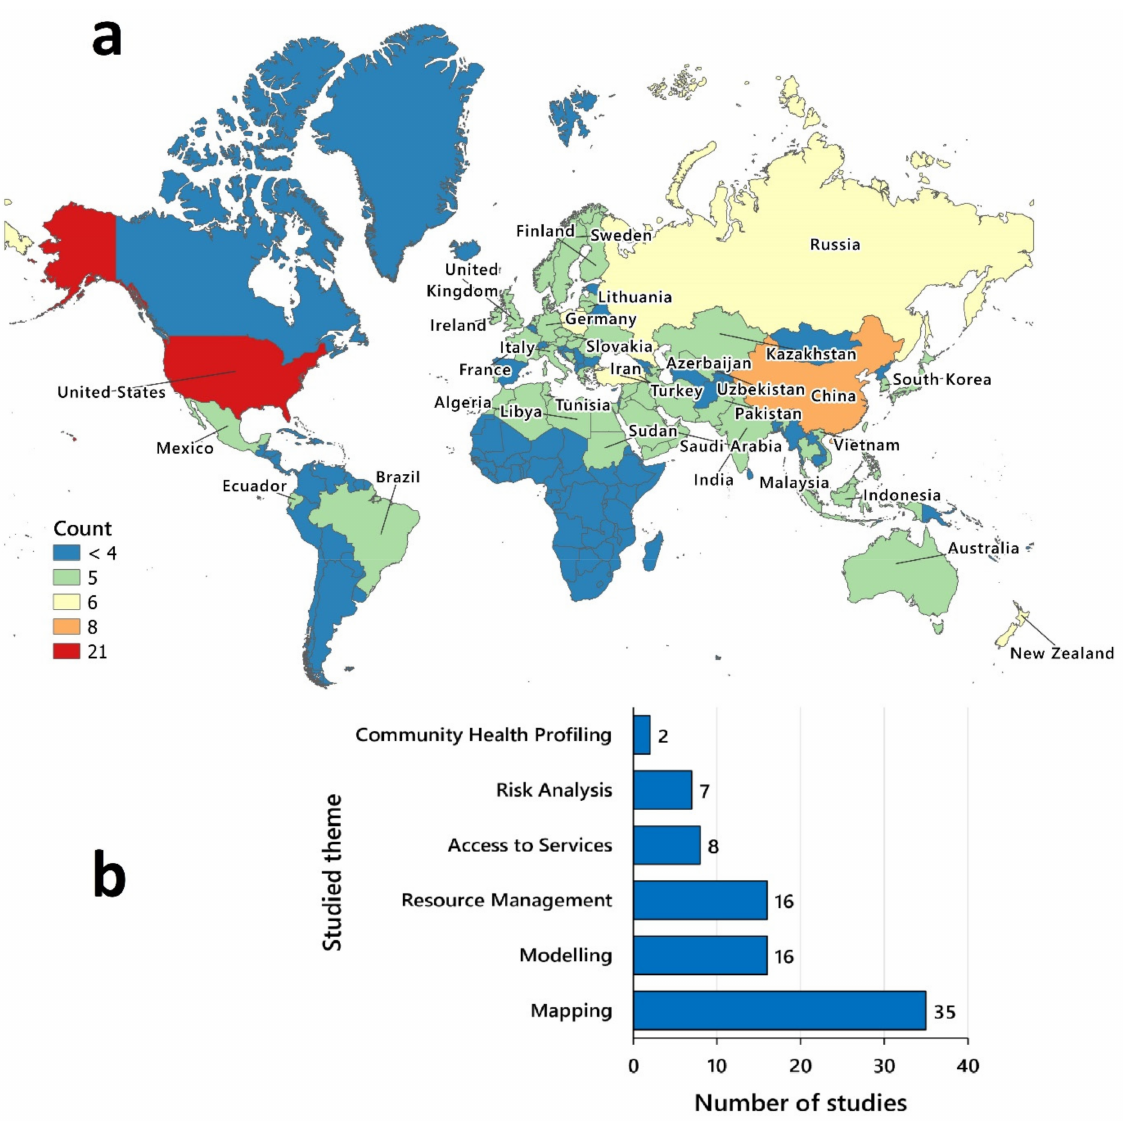
Figure 2. The number of selected studies based on ( a ) geographic distribution and ( b ) spatial analysis